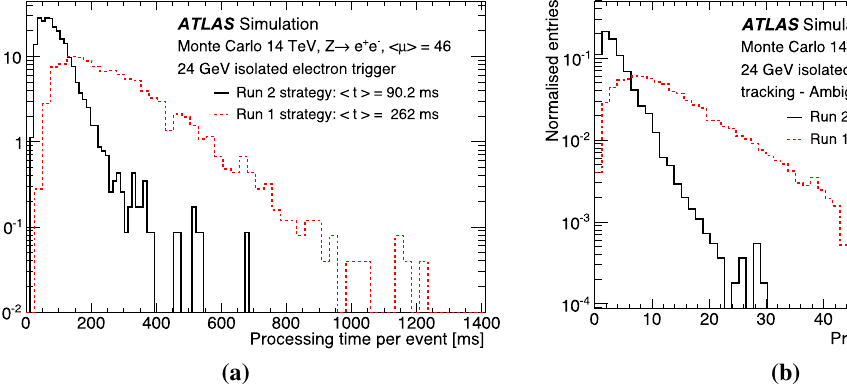
Fig. 4 The reduction in the latency for the Run 2 ID trigger strategy withrespecttotheRun 1strategy: a thetotaltimefortheisolated24GeV electron trigger with the Run 1 and Run 2 strategies; b the time taken